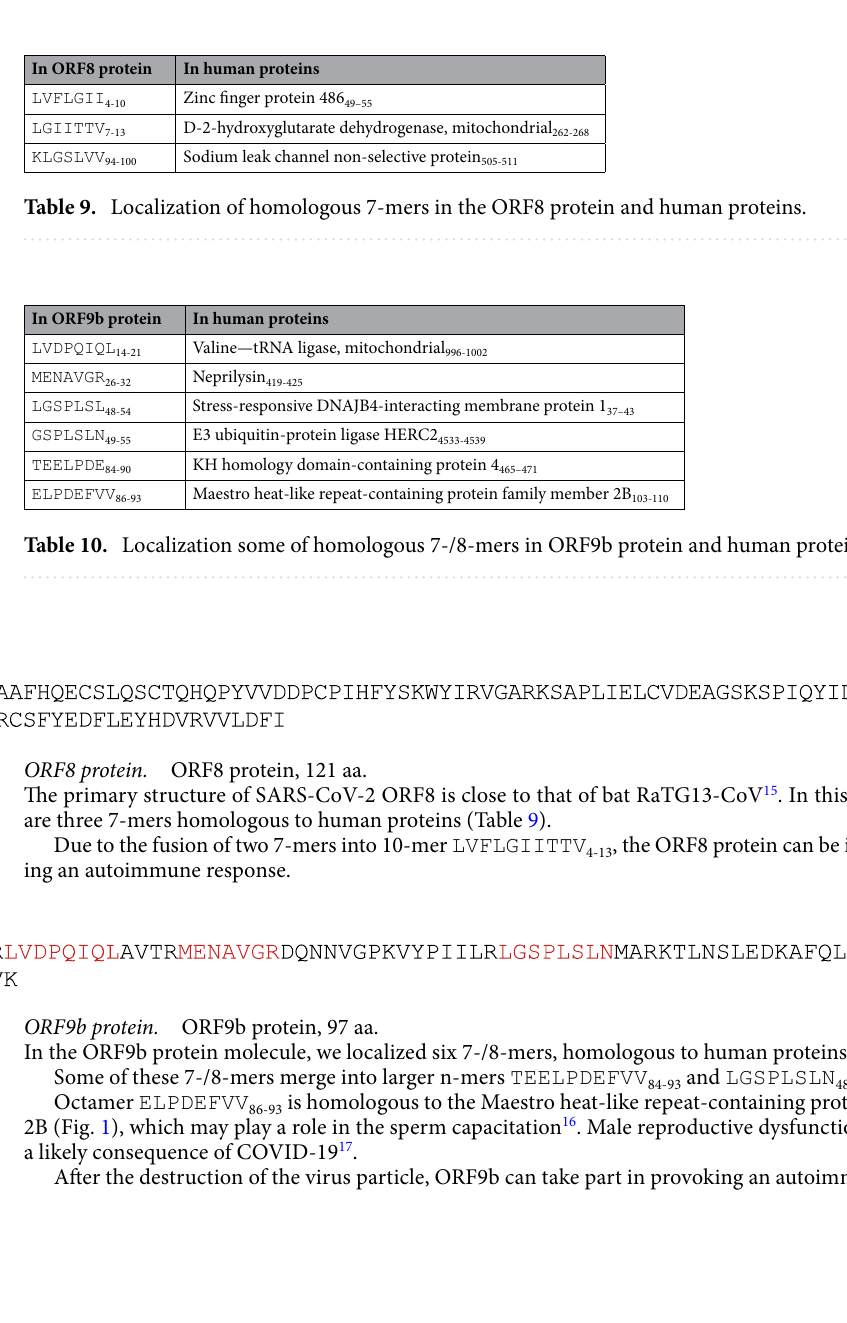
Table 8. Localization of the homologous 7-mer in ORF7b and a human protein.